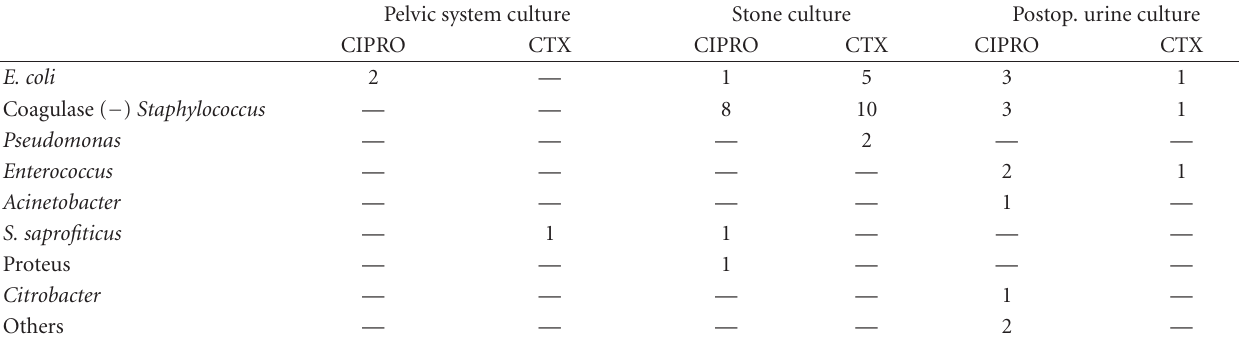
Table 4: Distribution of isolated microorganisms between antibiotic